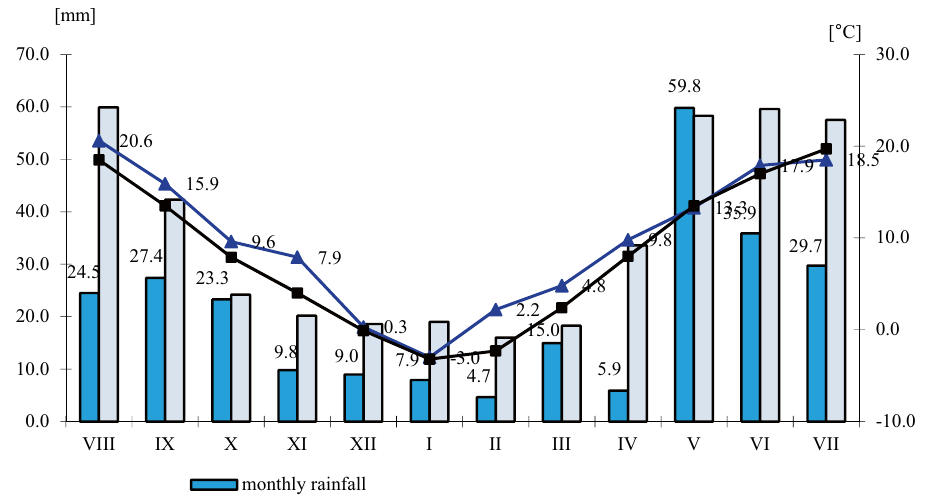
Figure 4. Monthly rainfall totals and average air temperature during the growing season 2018–2019 in RSD Zawady of many years (1996–2010).